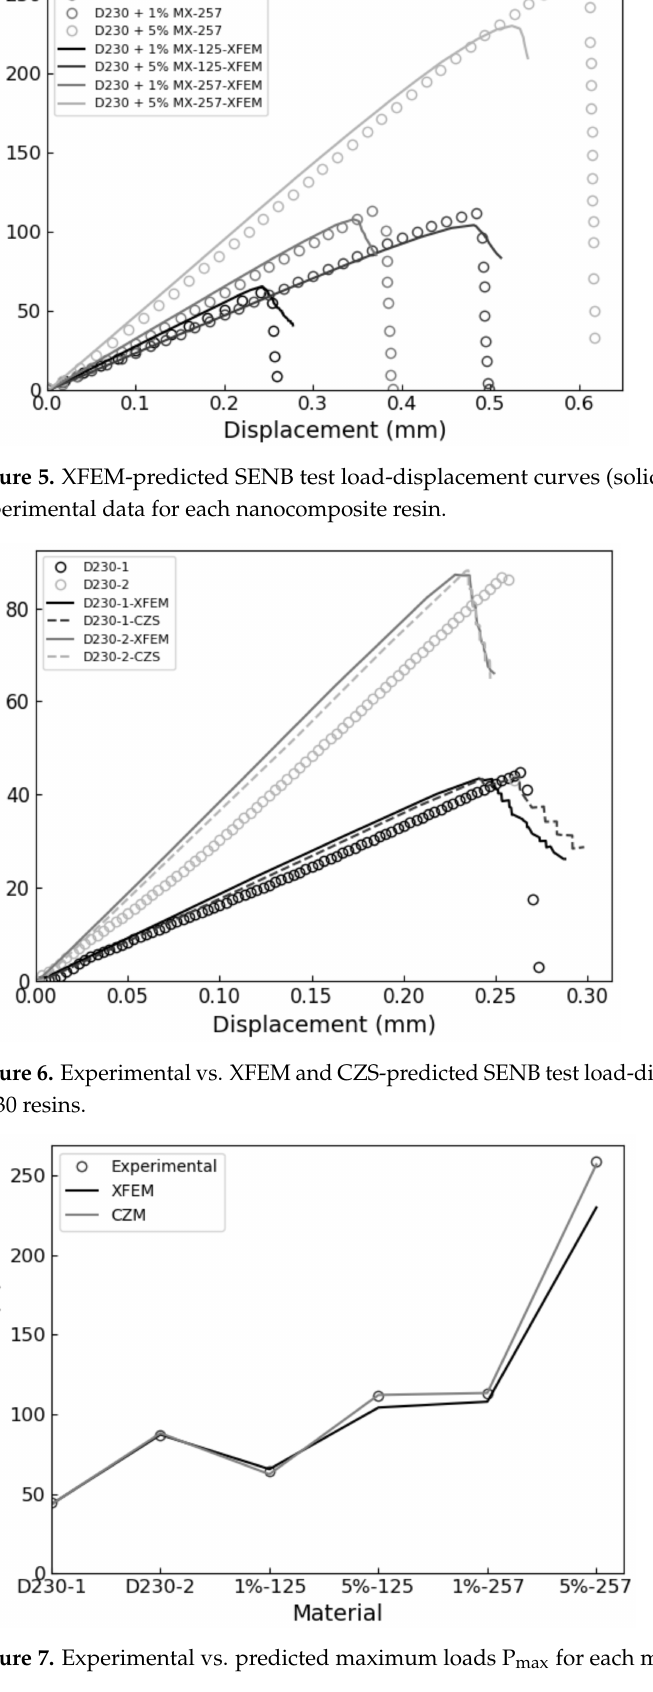
Figure 7. Experimental vs. predicted maximum loads P max for each